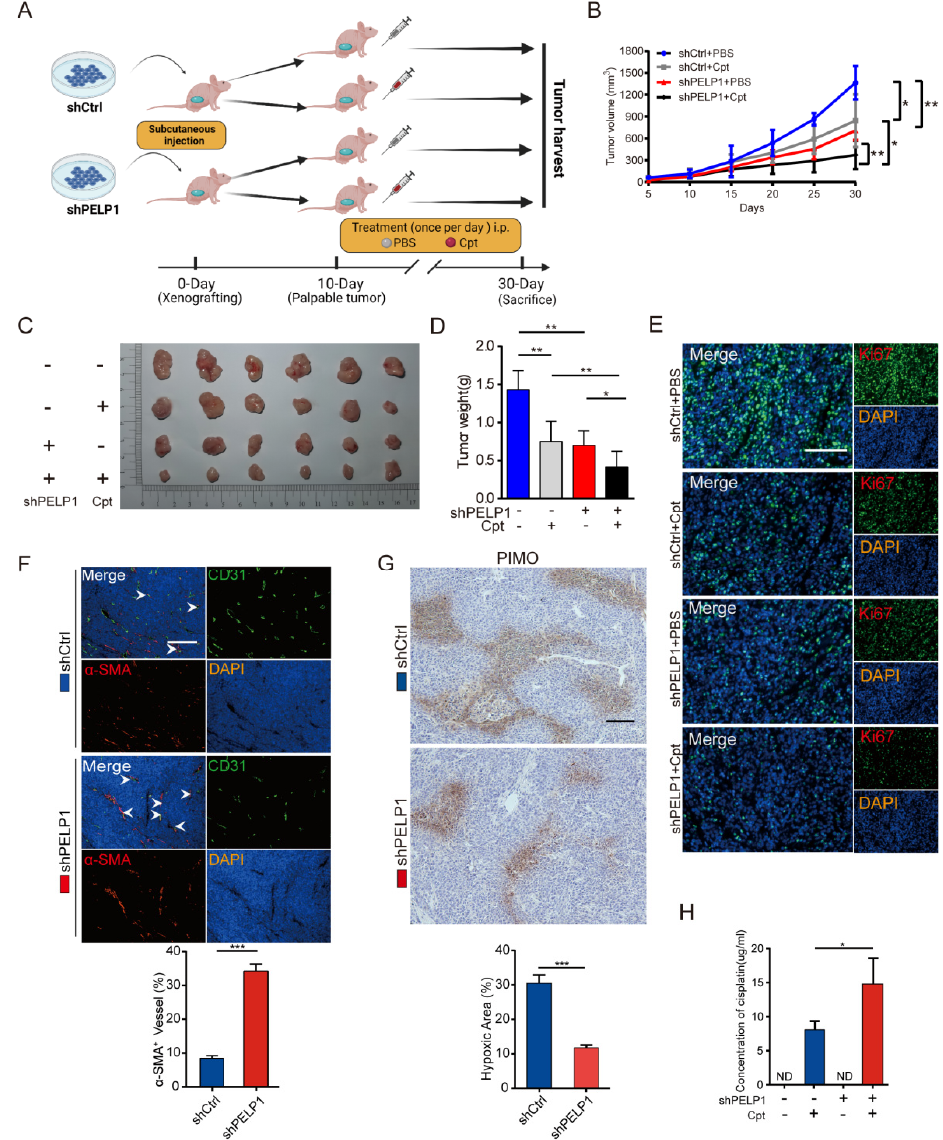
Figure 6. PELP1 suppression enhance efficacy of chemotherapy via vascular normalization: ( A ) Scheme indicating the timing of xenografting and longitudinal treatment. ( B – D ) Growth curves ( B ), the harvest tumors ( C ) and the weight of tumors ( D ) derived from nude mice injected with HCT116 cells stably expressing shPELP1 or shCtrl and with or without Cpt. ( E ) Representative images of immunofluorescence for Ki67 in tumor derived from nude mice injected with HCT116 cells stably expressing shPELP1 or shCtrl and with or without Cpt. Scale bar: 100 µm. ( F ) Double immunostaining (upper) for CD31 (Green) and α -SMA (Red) in sections of tumors derived from nude mice injected with HCT116 cells stably expressing shPELP1 or shCtrl, and quantification (lower) of percentage of α -SMA+/CD31+ vessels to assess pericyte coverage. Scale bar: 200 µm. ( G ) Representative image (upper panel) and quantification (lower panel) of PIMO staining in tumors derived from nude mice injected with HCT116 cells stably expressing shPELP1 or shCtrl. Scale bar: 100 µm. ( H ) HPLC analysis of Cpt concentration in tumor derived from nude mice. Data are shown as the means of three independent experiments or representative data. Error bars indicate SD.* p < 0.05, ** p < 0.01, *** p < 0.001 by Student’s t -test.